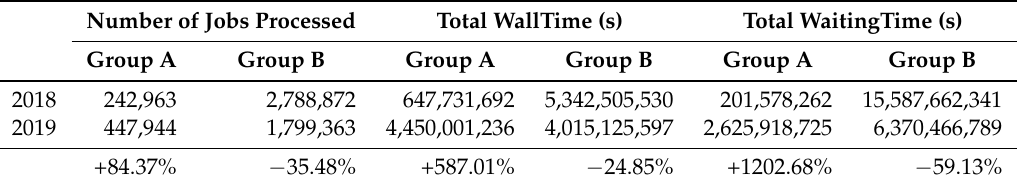
Table 2. Statistics for submission jobs in 2018 and 2019.